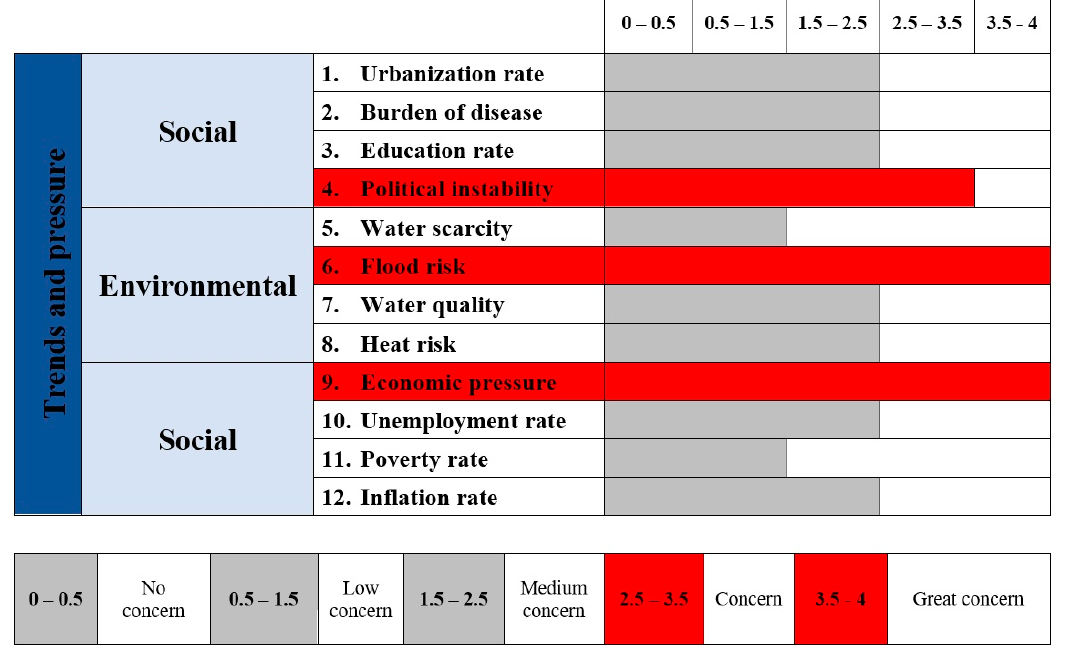
Figure 2. Results of the Trends and Pressures Framework analysis of Mongolia and Ulaanbaatar.